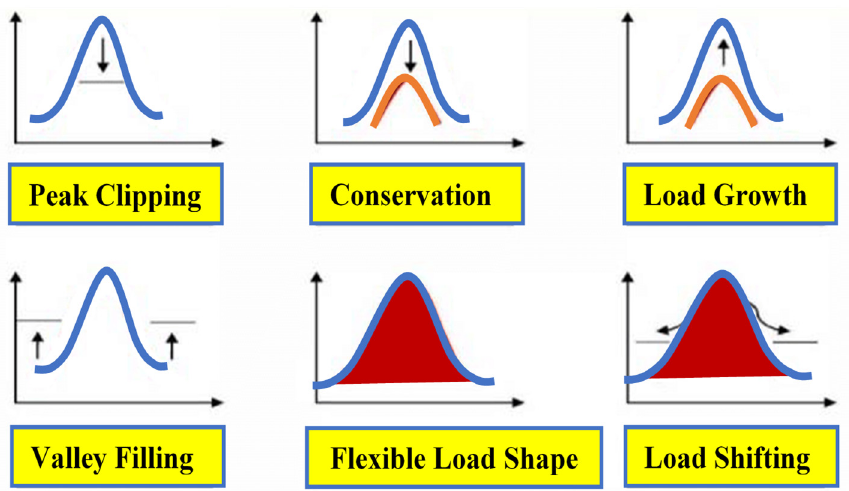
Figure 1. Techniques of DSM methodology.